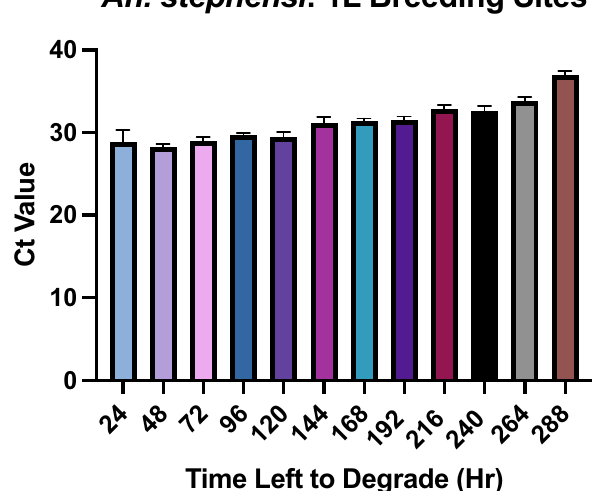
Figure 4. Rate of An. stephensi eDNA degradation over 12 days. qPCR detection for all extractions were run in technical triplicate. Error bars indicate 95% confidence intervals (CIs).